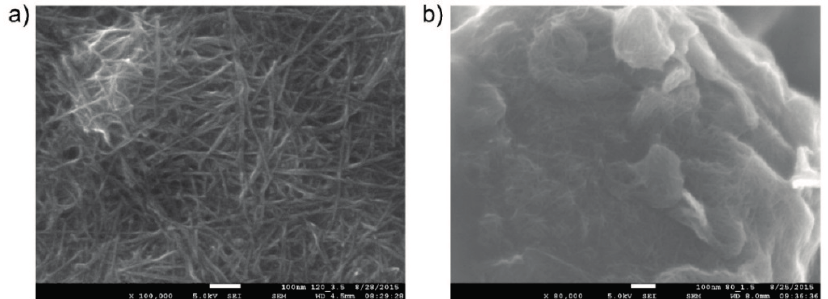
Figure 2. ( a ) Reference layer of carbon nanotubes on a flat surface (JEOL JSM